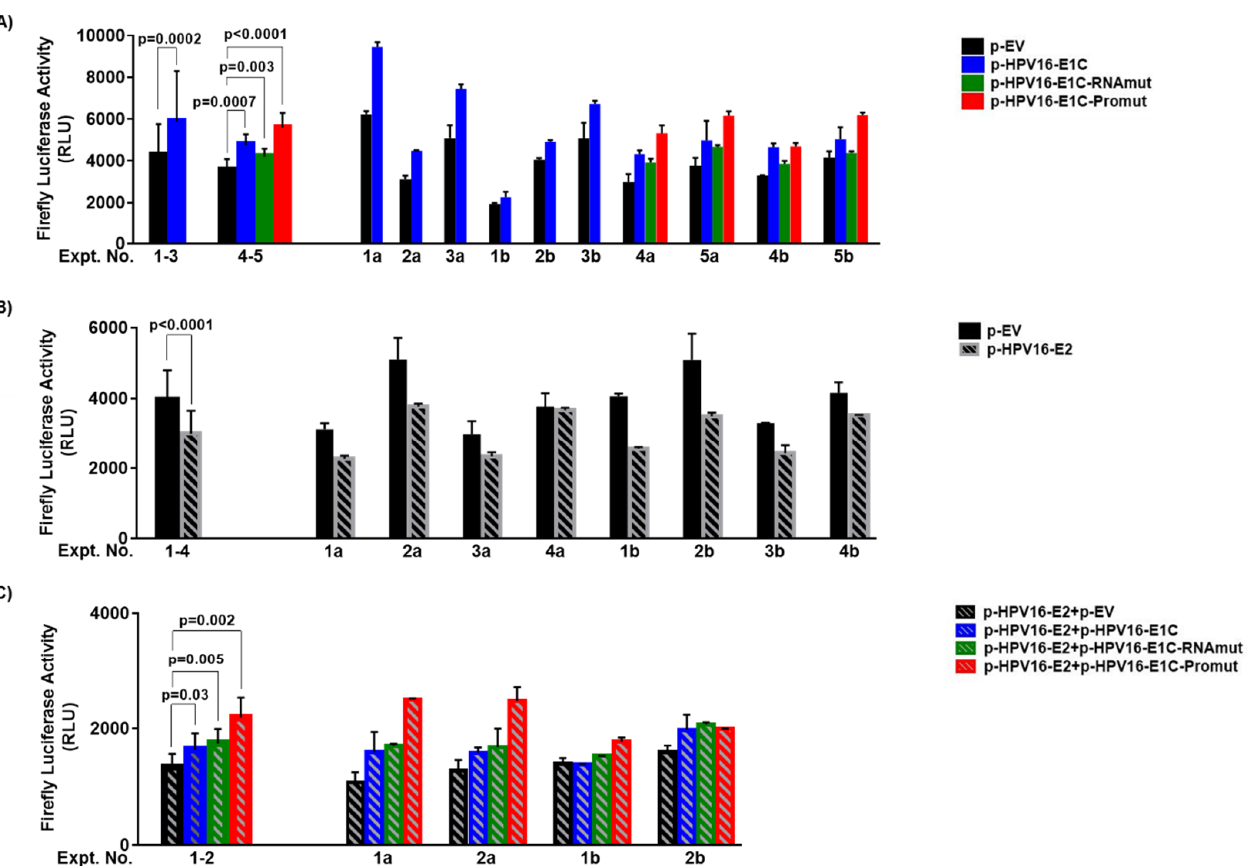
Figure 2. Effect of wild type and mutant E1C expression plasmids on HPV16 upstream regulatory region (URR) without and with E2 plasmid co-transfection. HEK-293T cells were co-transfected with 400 ng of p-HPV16-URR-FLuc reporter plasmid and ( A ) 100 ng of either p-EV, p-HPV16-E1C (number of experiments, n = 6), p-HPV16-E1C-RNAmut ( n = 4) or p-HPV16-E1C-Promut ( n = 4), ( B ) 100 ng of p-HPV16-E2 ( n = 8), ( C ) the same plasmids as in ( A ) always together with 100 ng of p-HPV16-E2 ( n = 4). Firefly luciferase signals (RLU, Relative Light Units) are shown on the y-axis. Mean and standard deviation of all experiments combined and of duplicates from the individual experiments (numbered below x-axis) are shown on the left and right, respectively. p values are from paired t test. Letters a and b in experimental numbers indicate experiments without and with additional co-transfection of 2.5 ng of p-TATAbox-RLuc, respectively.